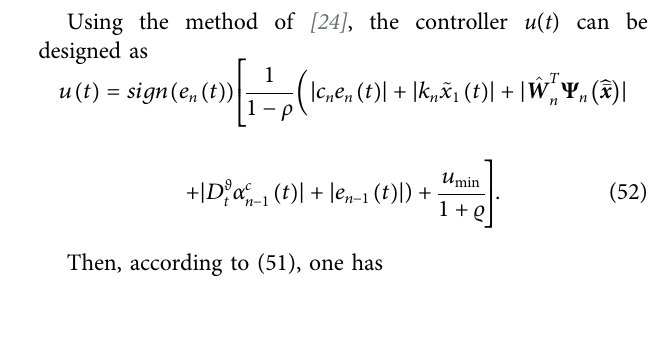
Frontiers in Physics |